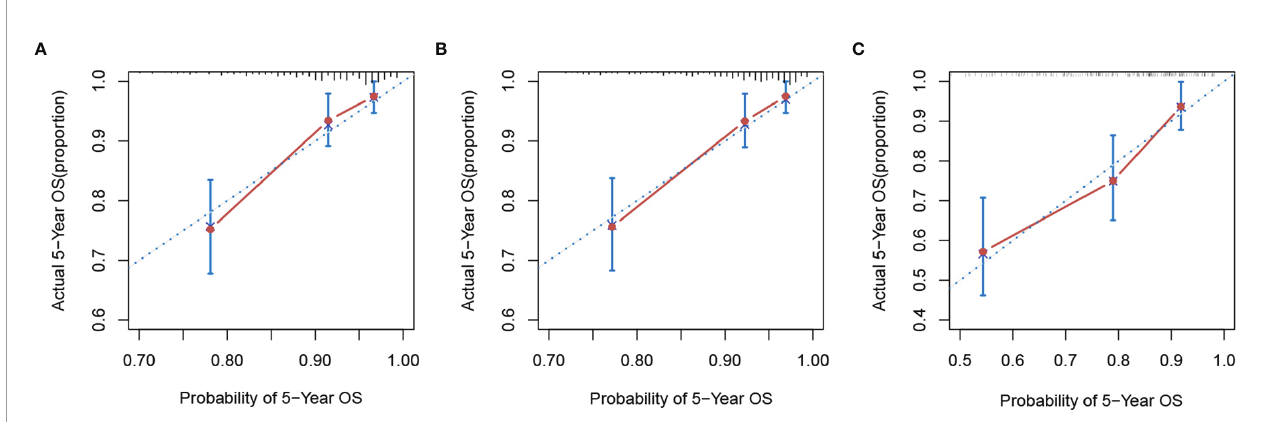
FIGURE 9 | The calibration curve of nomograms for predicting 5-year overall survival. (A) Conventional nomogram and (B) SII-based nomogram in the training group. (C) SII-based nomogram in the validation group. SII, systemic immune-in fl ammation index.